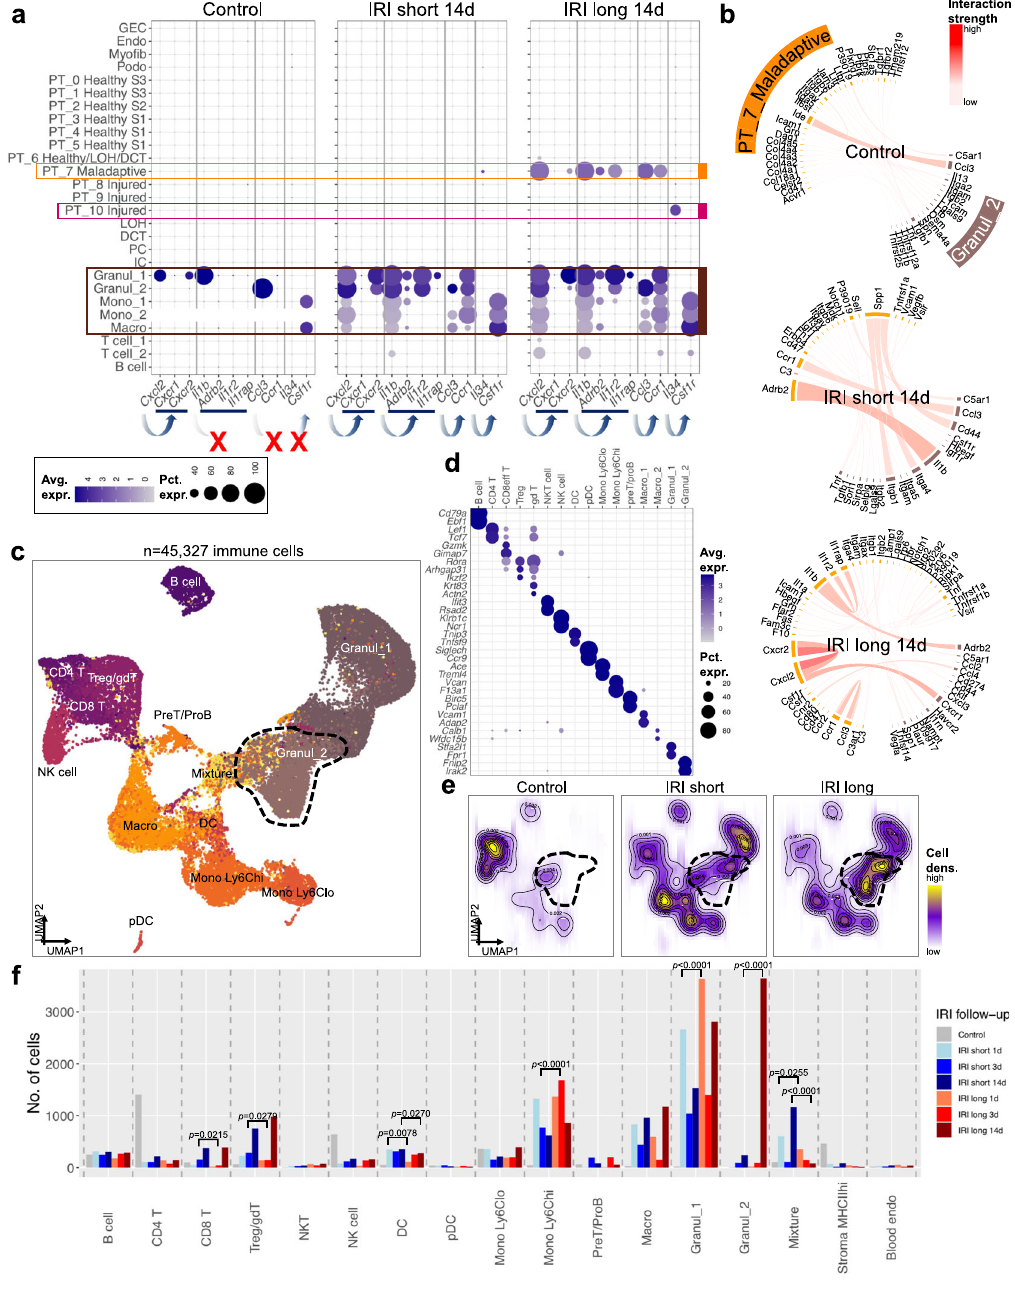
Fig. 7 Transcriptional atlas of immune cells in adaptive and maladaptive kidneys. a Dot plots showing an increase of expression of genes corresponding to proin fl ammatory cell – cell interactions among myeloid cells after IRI. 14 d after long IRI, maladaptive PT adopts an immune cell phenotype. Dot size denotes percentage of cells expressing the marker. Color scale represents average gene expression values. Arrows indicate ligand – receptor pairs, as derived from CellPhoneDB. X denotes abrogated signaling. b Circos plots visualizing genes involved in ligand – receptor interaction between PT_7_Maladaptive and corresponding interaction partner cells (Granul_2). Color scale is proportional to interaction strength, as measured by CellPhoneDB interaction means of statistically signi fi cant interactions. Note that signaling is both between epithelium and myeloid cells as well as exclusively among epithelium. c UMAP projection of 45,327 immune cells. Clusters encompassed B cells, CD4 and CD8 T cells, regulatory and ɣ δ T cells (Treg/gdT), natural killer T cells (NKT), natural killer (NK) cells, dendritic cells (DC), plasmacytoid DC (pDC), monocytes with high and low expression of Ly6C, respectively (Mono Ly6C lo , Mono Ly6C hi ), PreT/proB precursor cells, macrophages (Macro), Granulocytes (Granul_1, Granul_2), a mixed phenotype cluster (Mixture), MHCII expressing stroma cells (Stroma MHCII hi ), and blood endothelial cells (Blood endo). d Dot plot showing cell type-speci fi c expression patterns of marker genes. Dot size denotes percentage of cells expressing the marker. Color scale represents average gene expression values. e Changes in cell proportions of immune cell types between treatment groups are visualized as cell density. Cells from Control samples were most dense in T cell clusters, those from IRI short samples in Macro, Mono Ly6C hi , and Granul_1 clusters, and those from IRI long samples in the Granul_2 cluster. f Bar graph depicting the number of different immune cells ( n = 45,327 total cells) according to treatment group (Control; IRI short; IRI long) and according to time point after ischemia (13, and 14 d). Statistical signi fi cance for comparisons between short and long IRI was derived using differential proportion analysis, with a mean error of 0.1 over 100,000 iterations; p values are given for time point comparisons between IRI short and long. NATURE COMMUNICATIONS| (2022) 13:4018